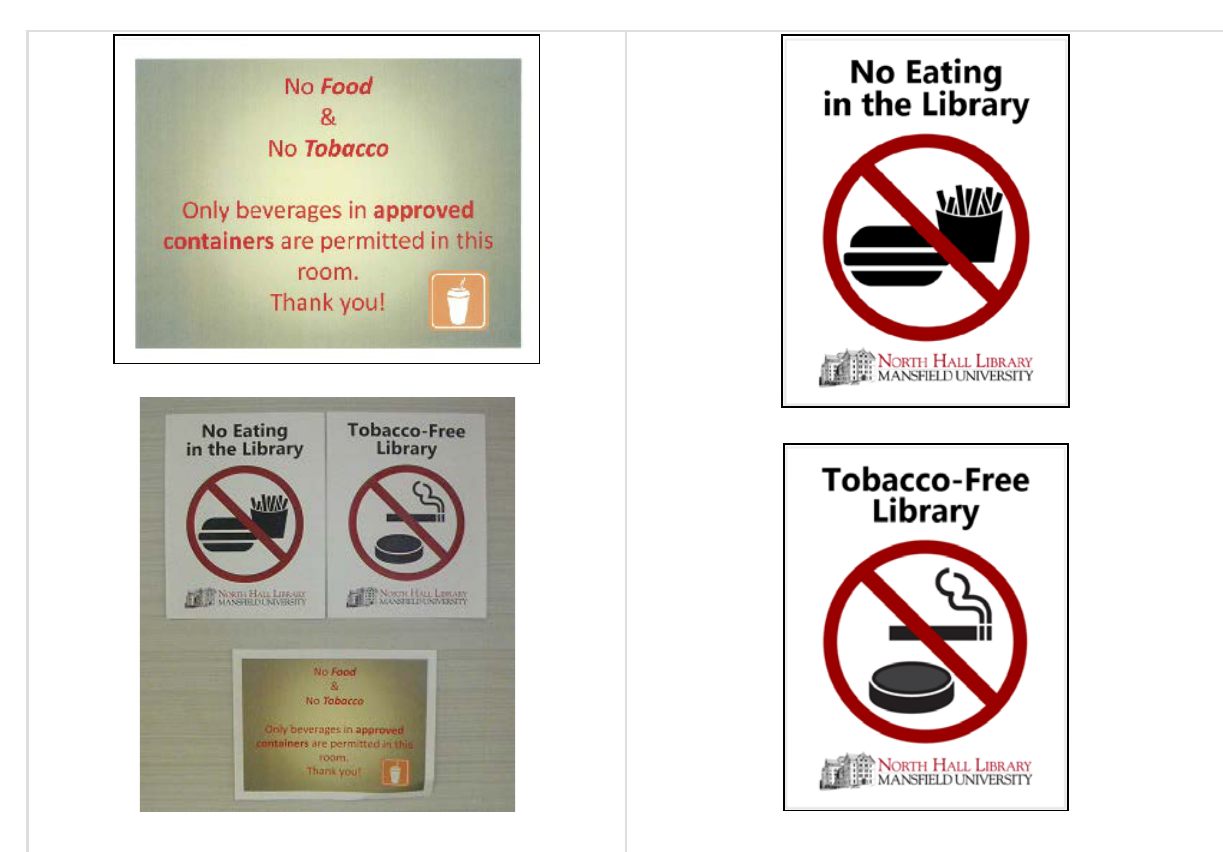
The single sign (top left) for food and drink rules lacks sufficient contrast and does not draw patrons’ attention. The before-and- after signs are posted on the same wall for ease of comparison (bottom left). The individual signs (right) with clear pictograms of sufficient size and contrast are harder to ignore.